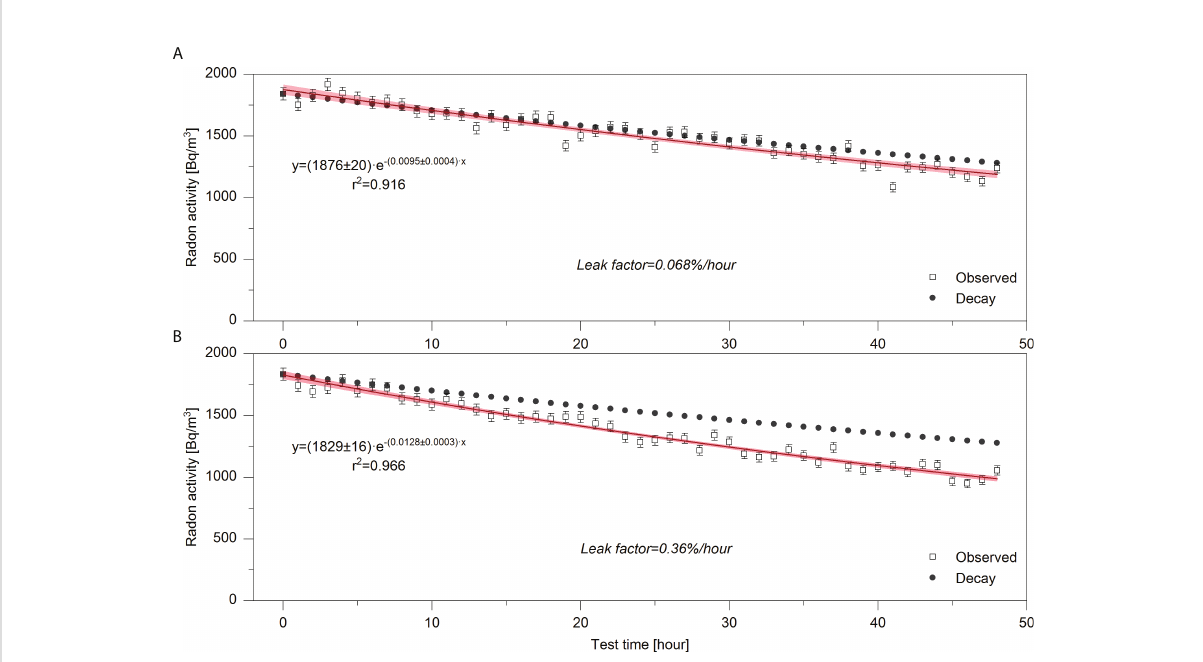
FIGURE 3 The radon activity in a closed air loop observed by PIC sensor (open squares) over time compared to the theoretical 222 Rn decay (solid dashes) with the air pump turning off (A) or with air pump running (B) , respectively. The red shadow areas shown the 95% con fi dent interval based on observed